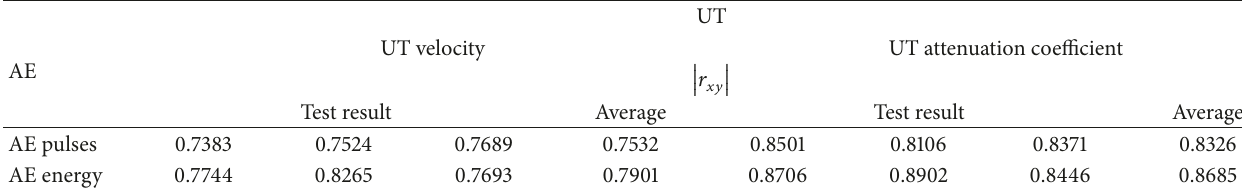
Table 3: Correlation coefficient between AE and UT